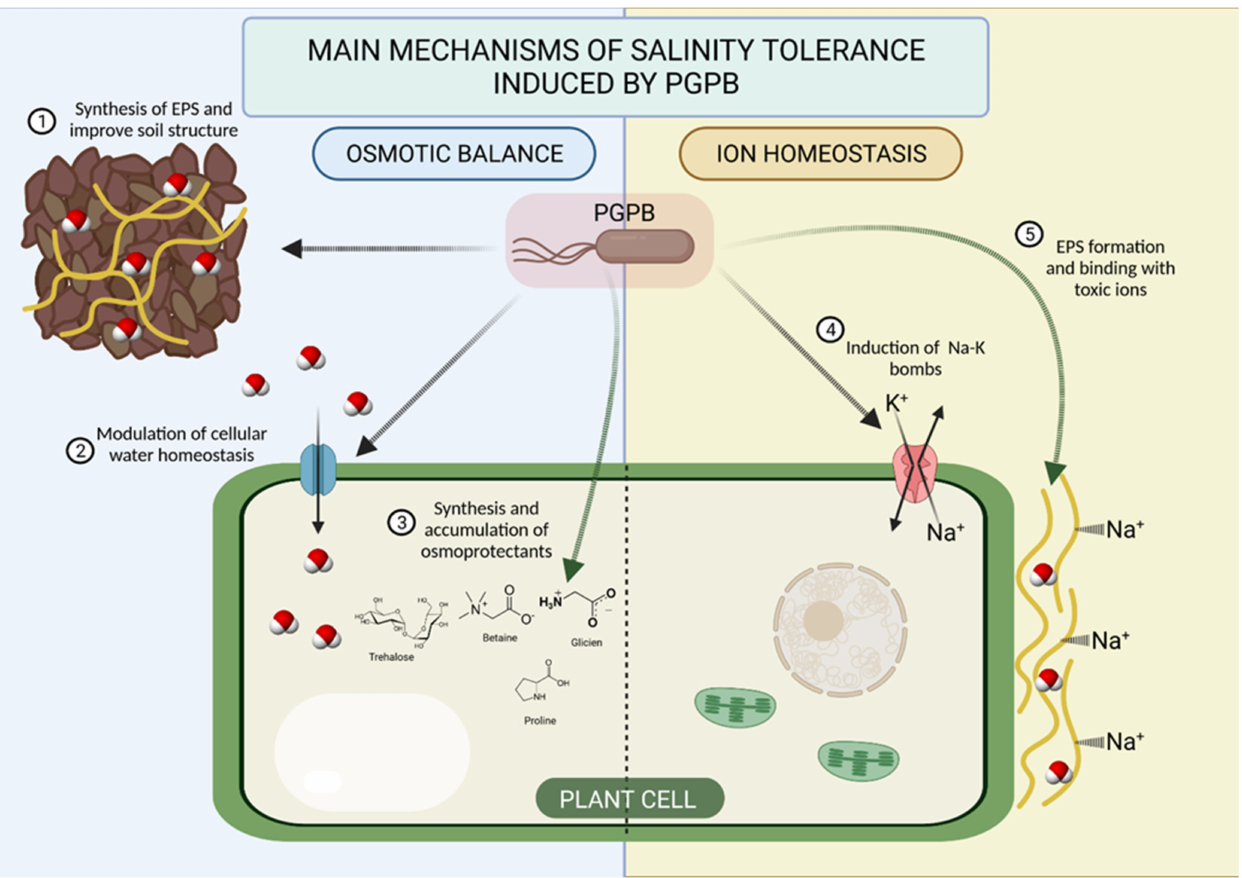
Figure 1. Main mechanisms of salinity stress tolerance induced by Plant Growth Promoting